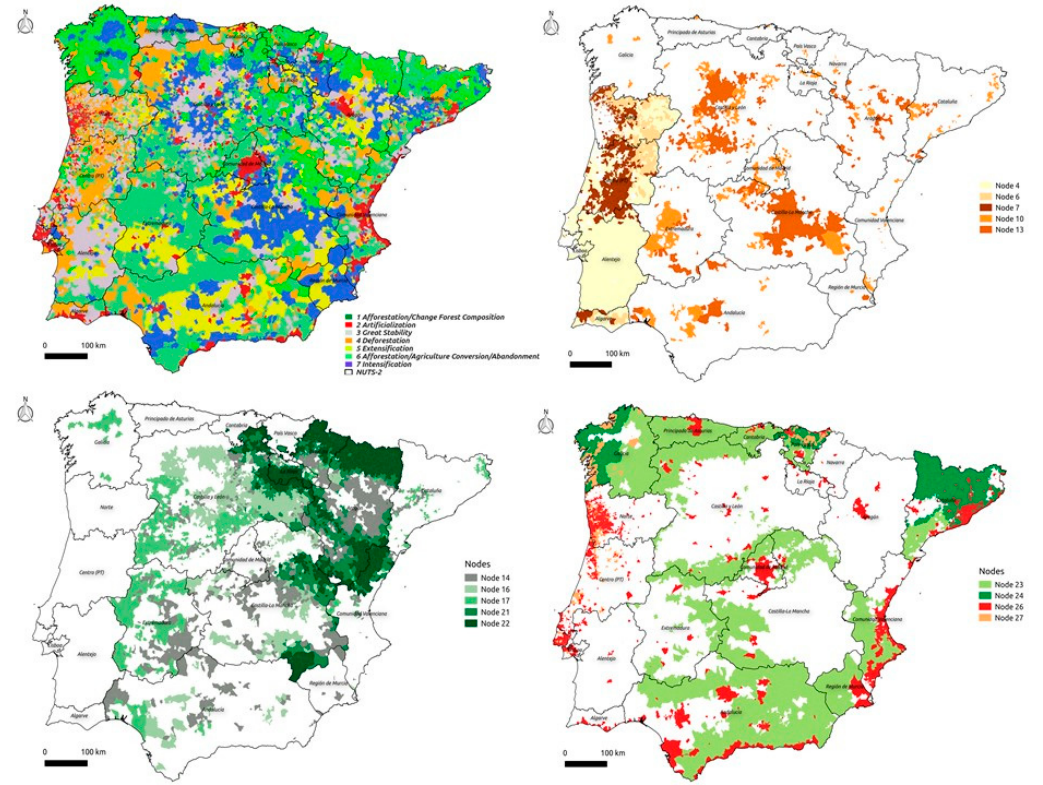
Figure 3. Comparison of the original classification (above, left) and the resulting nodes of the fitted tree (these are divided in three maps to improve readability).